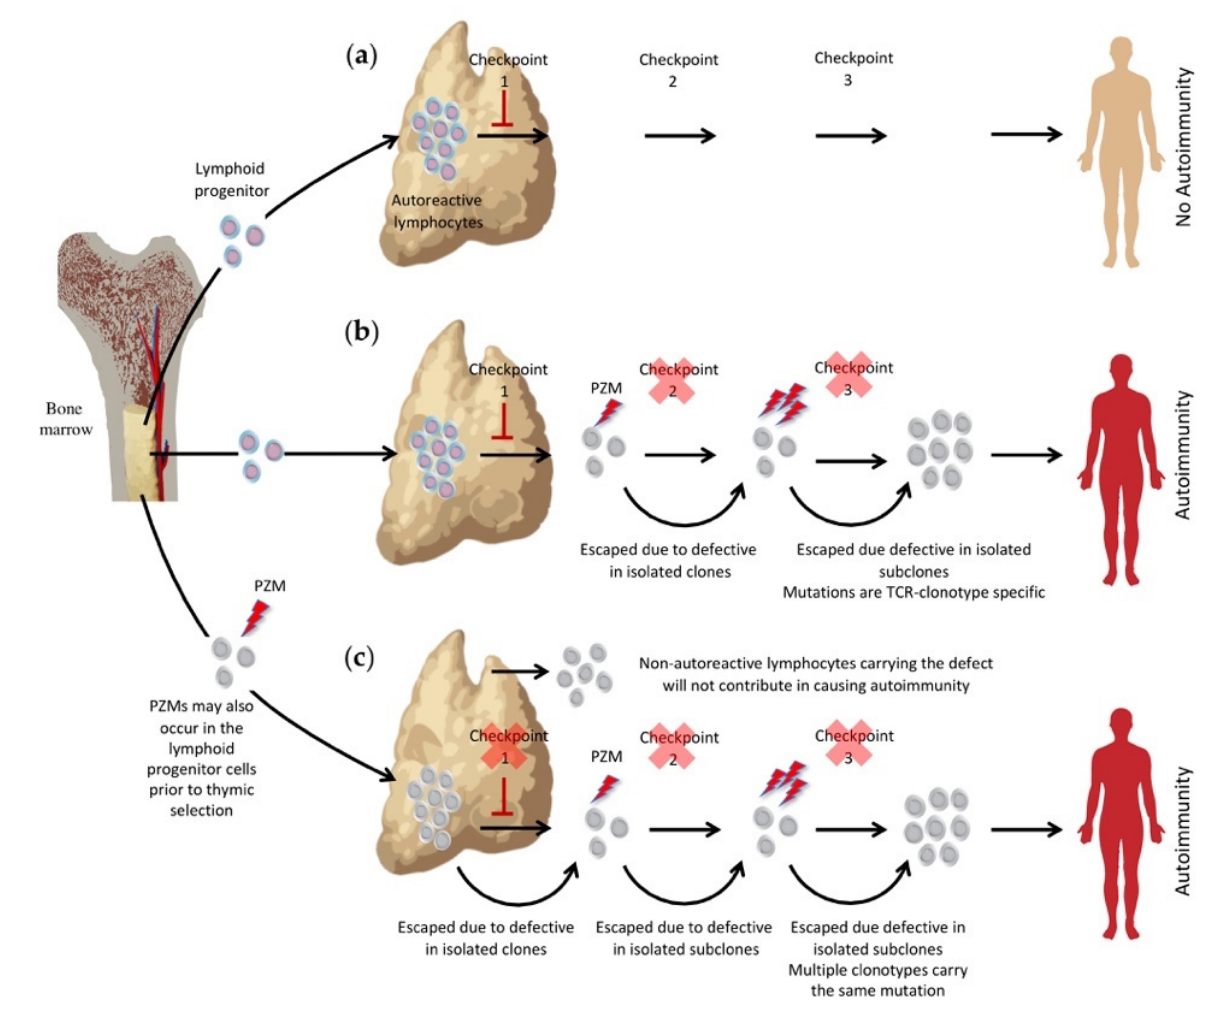
Figure 1. The somatic mutation hypothesis. Many lymphocytes clones, generated in the bone marrow, carry autoreactive receptors. ( a ) Normally, the generated autoreactive lymphocyte clones are eliminated by multiple growths and survival checkpoints, preventing autoimmunity; ( b ) post-thymic somatic mutations (lightning bolt) in a self-reactive lymphocyte clone (mutated cells in grey) might allow its bypass of these checkpoints and the potential accumulation of further mutations disrupting other checkpoints, causing the onset of stochastic autoimmunity; ( c ) somatic mutation events might take place pre-thymic in bone marrow progenitor cells and not in the antigen-specific lineage. Here, lymphocytes with no autoreactive receptors will not contribute in causing autoimmunity.